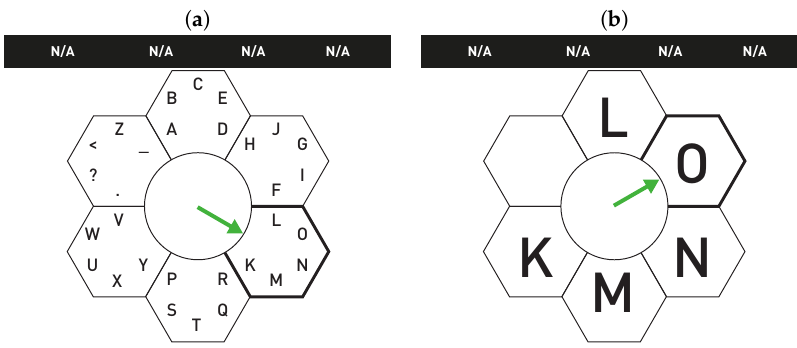
Figure 13. The GUI similar to Berlin Hex-O-Spell GUI, as shown and discussed in Blankertz et al., 2006 [39] ( a ) during the first stage of selection and ( b ) the second stage for selecting an individual letter. Figures modified from